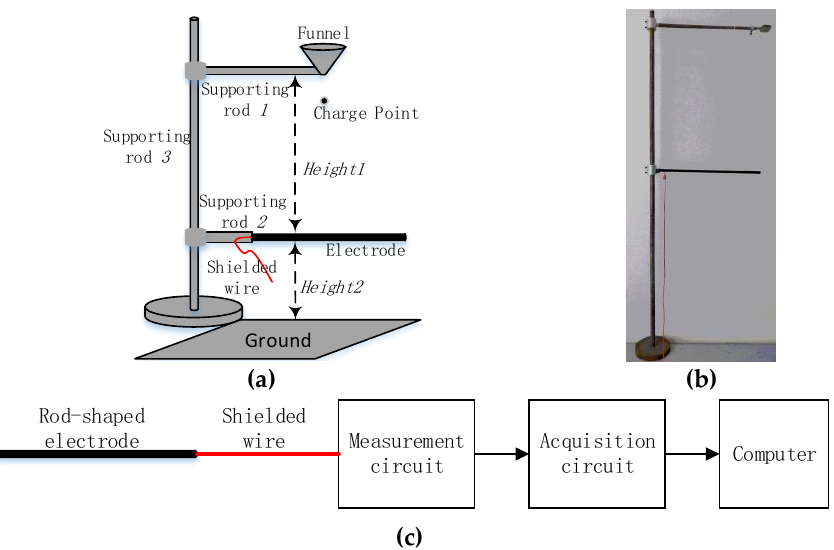
Figure 19. Experimental setup: ( a ) Schematic of the experimental system; ( b ) picture of the rod electrode employed; and ( c ) schematic of the signal connection.